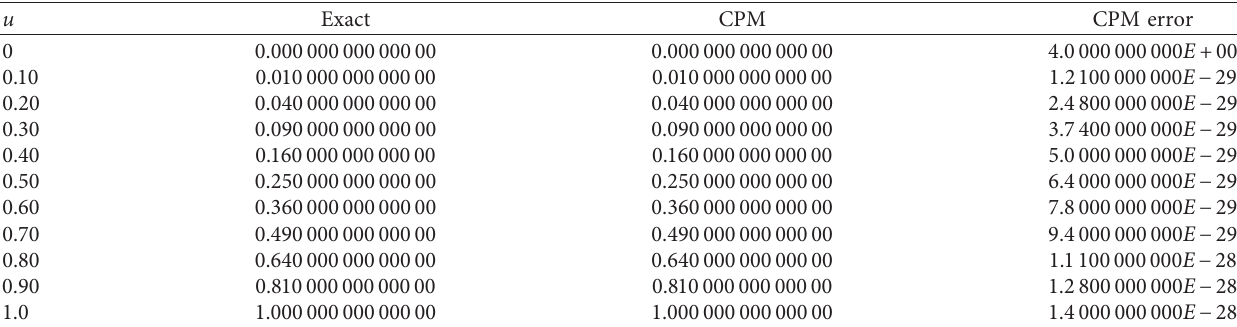
Table 5: Exact, CPM solution, and CPM A.E of problem 3 at m � 3.